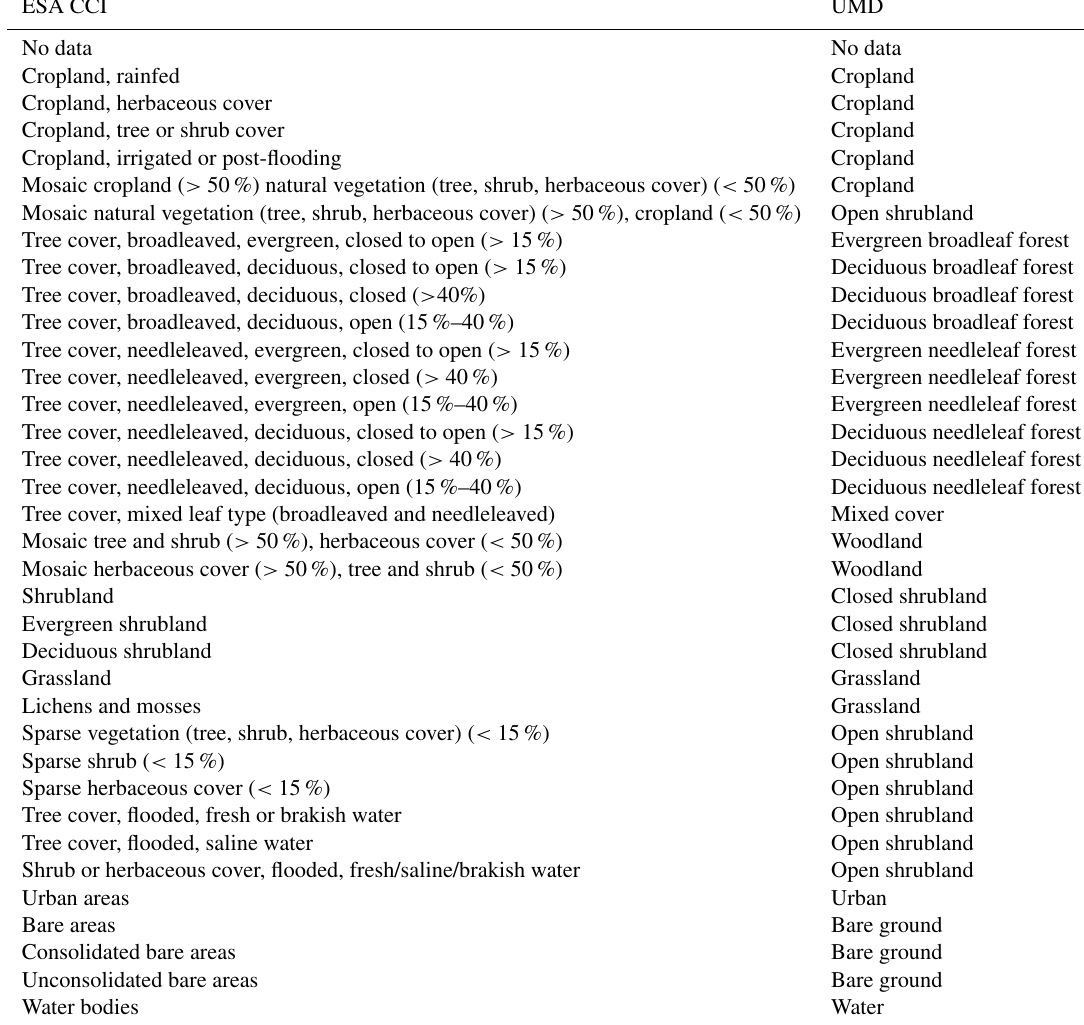
Table A1. Conversion from the ESA-CCI to the UMD land cover